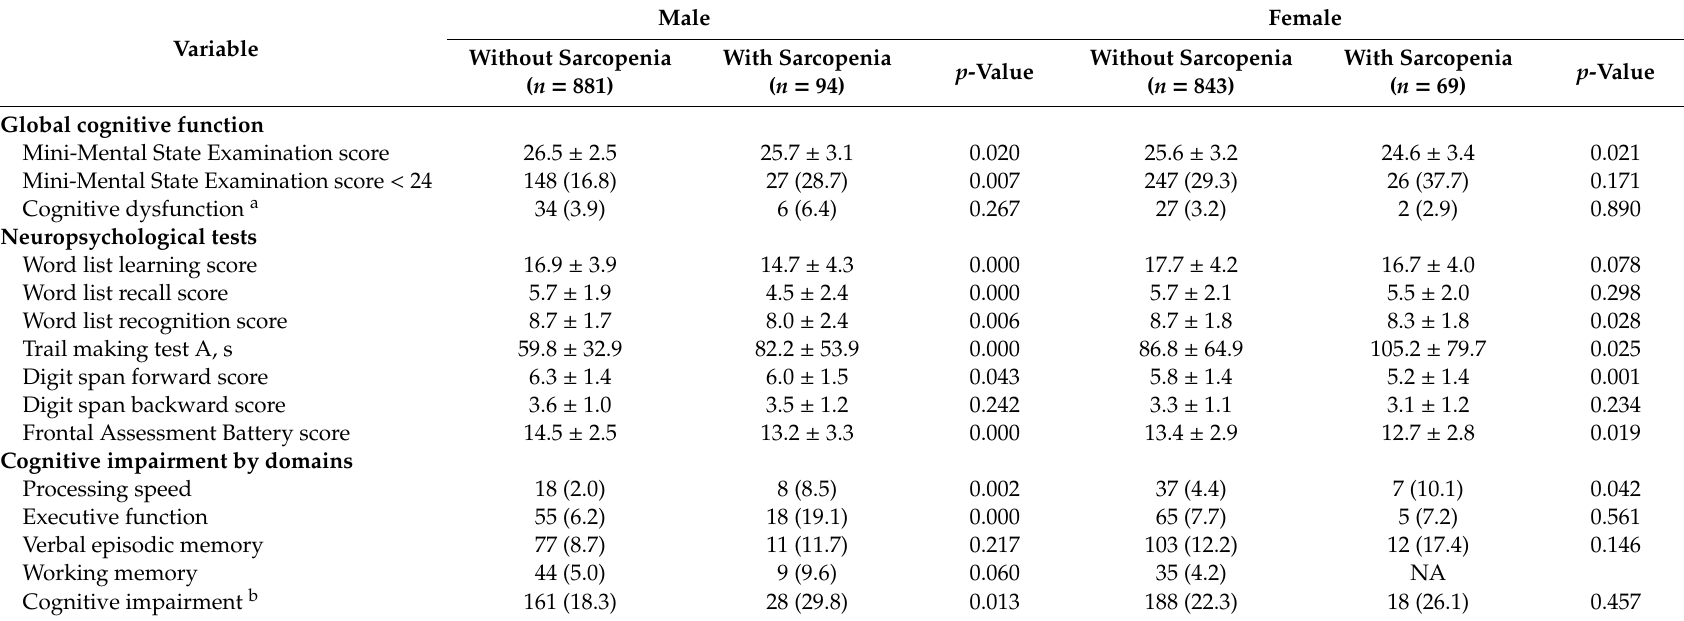
Table 2. Neuropsychological test scores according to sarcopenia by AWGS criteria. Male Female Variable Without